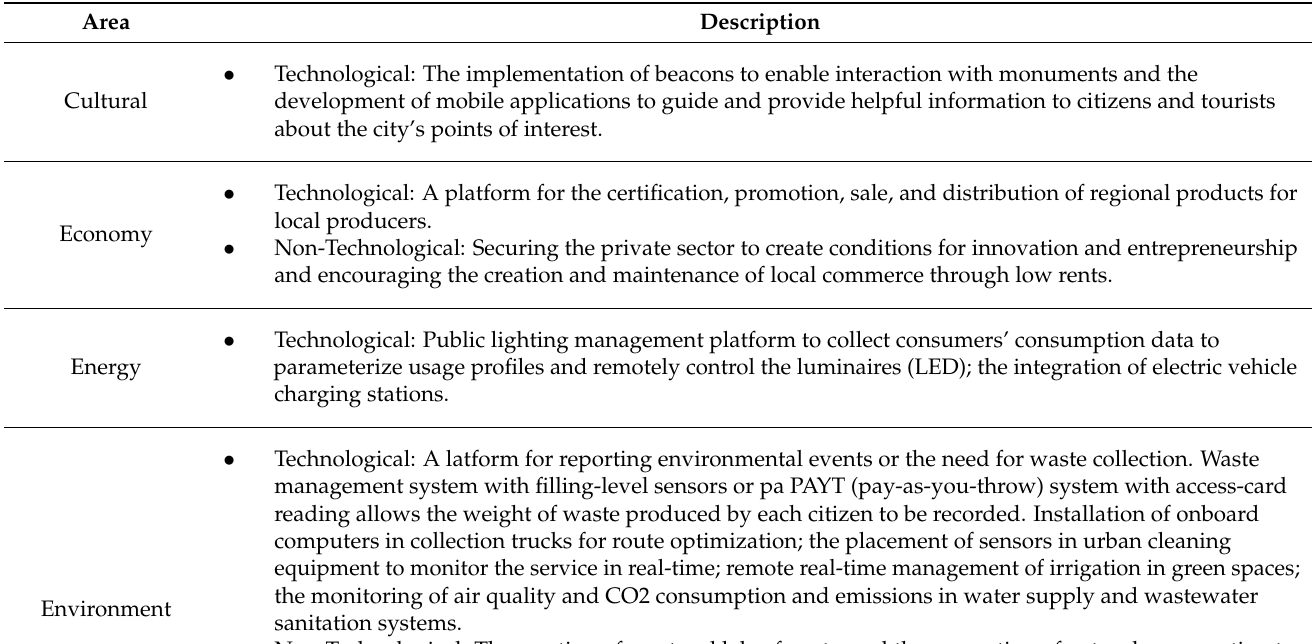
Table 3. Description of the smart-city initiatives according to their area and